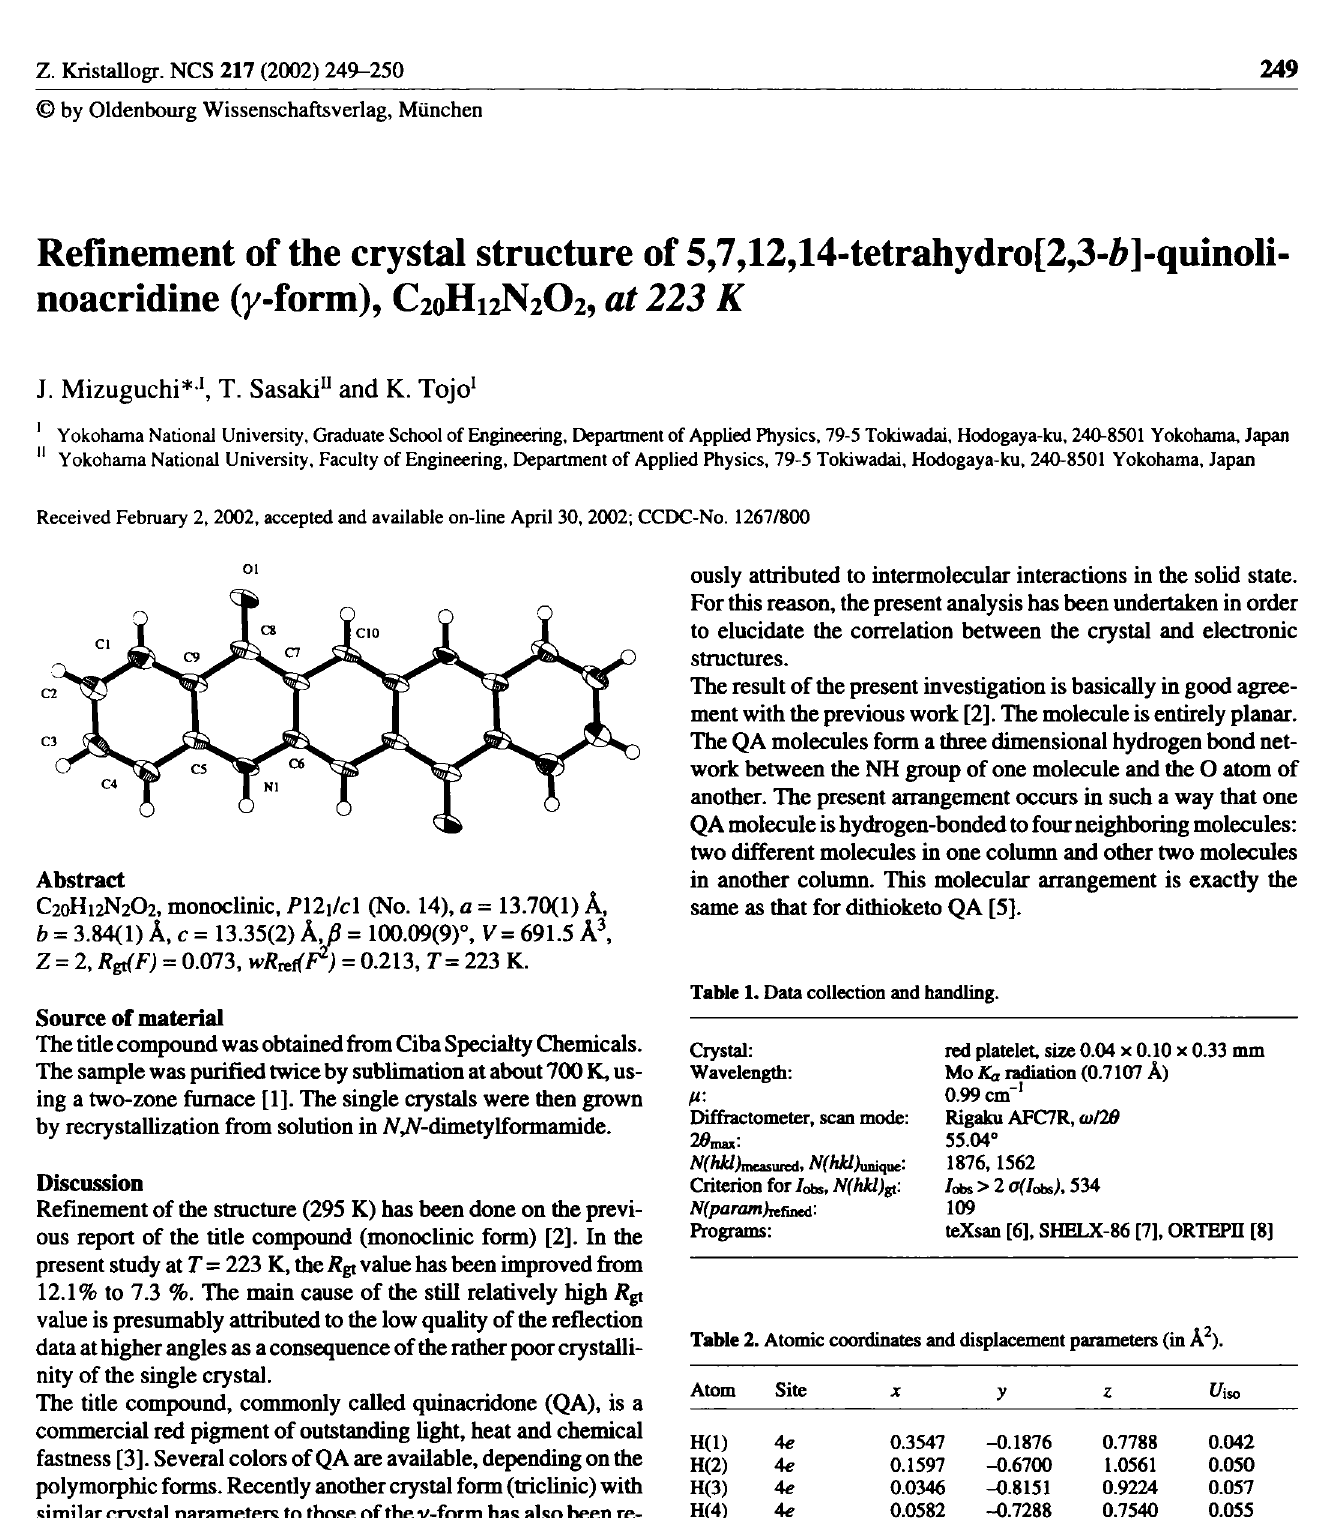
Table 2. Atomic coordinates and displacement parameters (in Â 2 ).